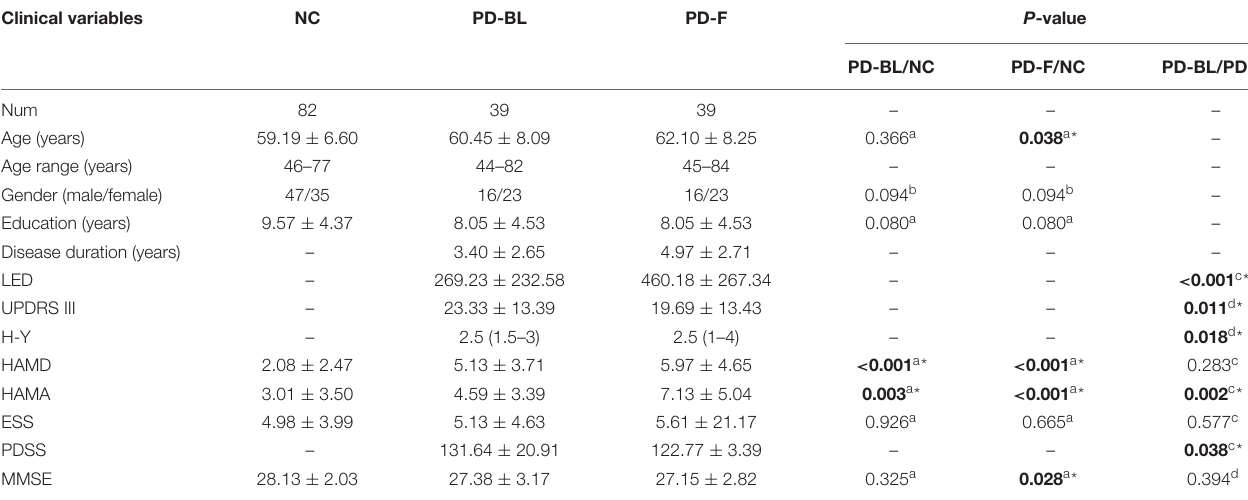
TABLE 2 | Demographic and clinical variables.